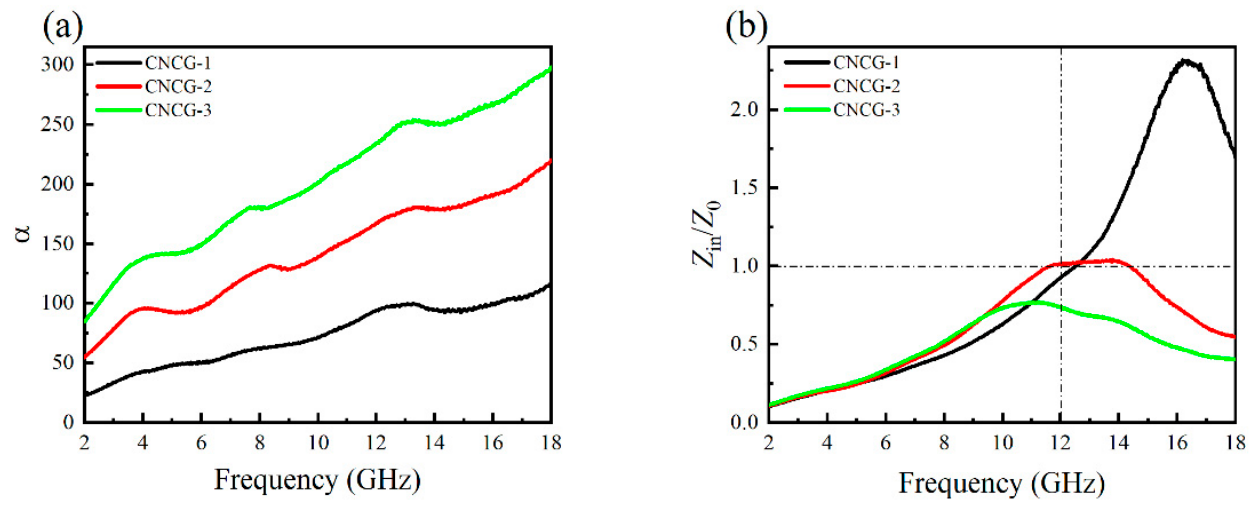
Figure 10. The α curve and | Z in / Z 0 | curve of CNCG. ( a ) The α curve of CNCG; ( b ) The | Z in / Z 0 | curve of